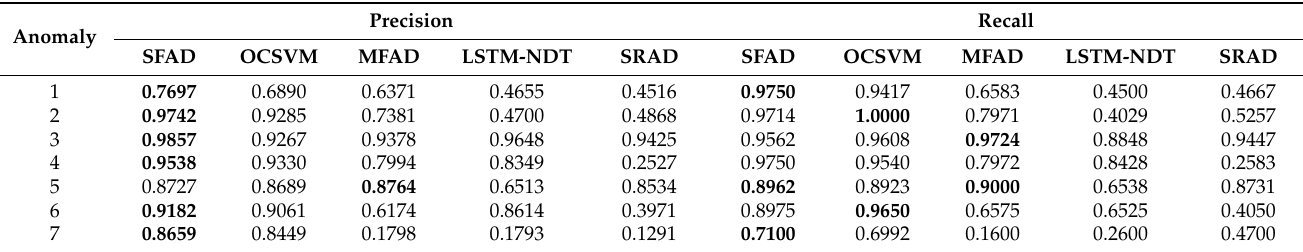
Table 2. Precision and recall comparison of anomaly detection.